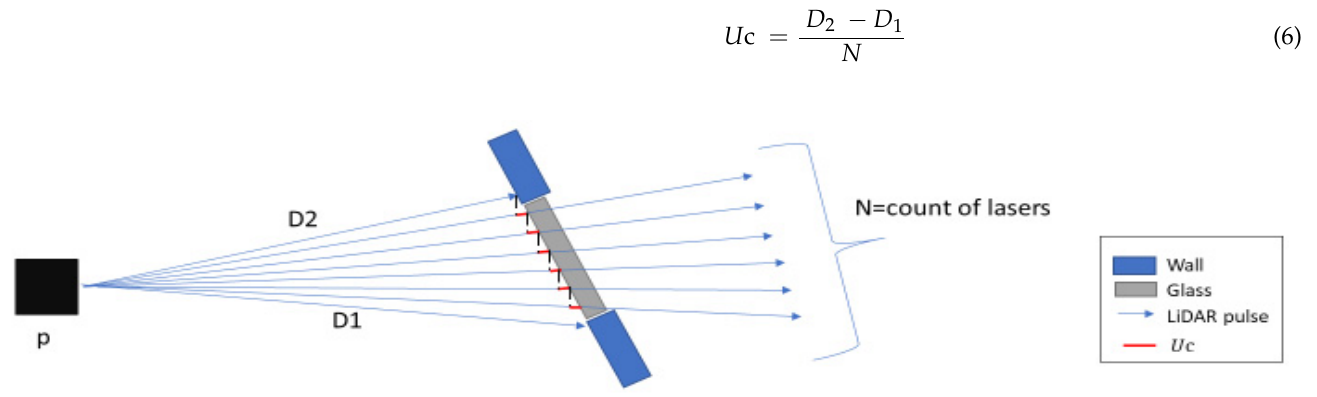
Figure 7. Illustration of how cartesian coordinates and range measurement is updated.